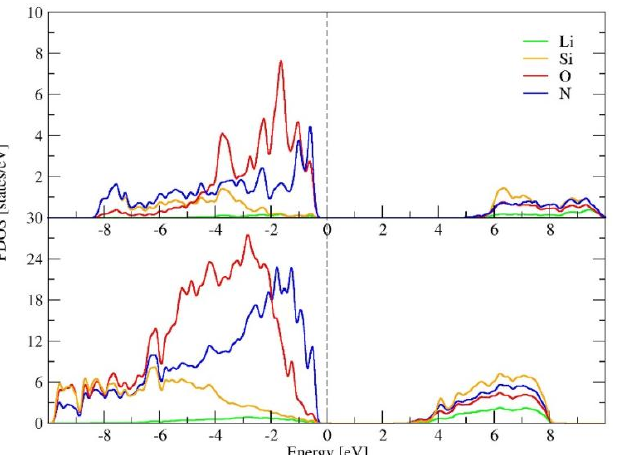
Figure 7. The density of states for α -LiSiON ( upper panel ) and amorphous-LiSiON ( lower panel ).